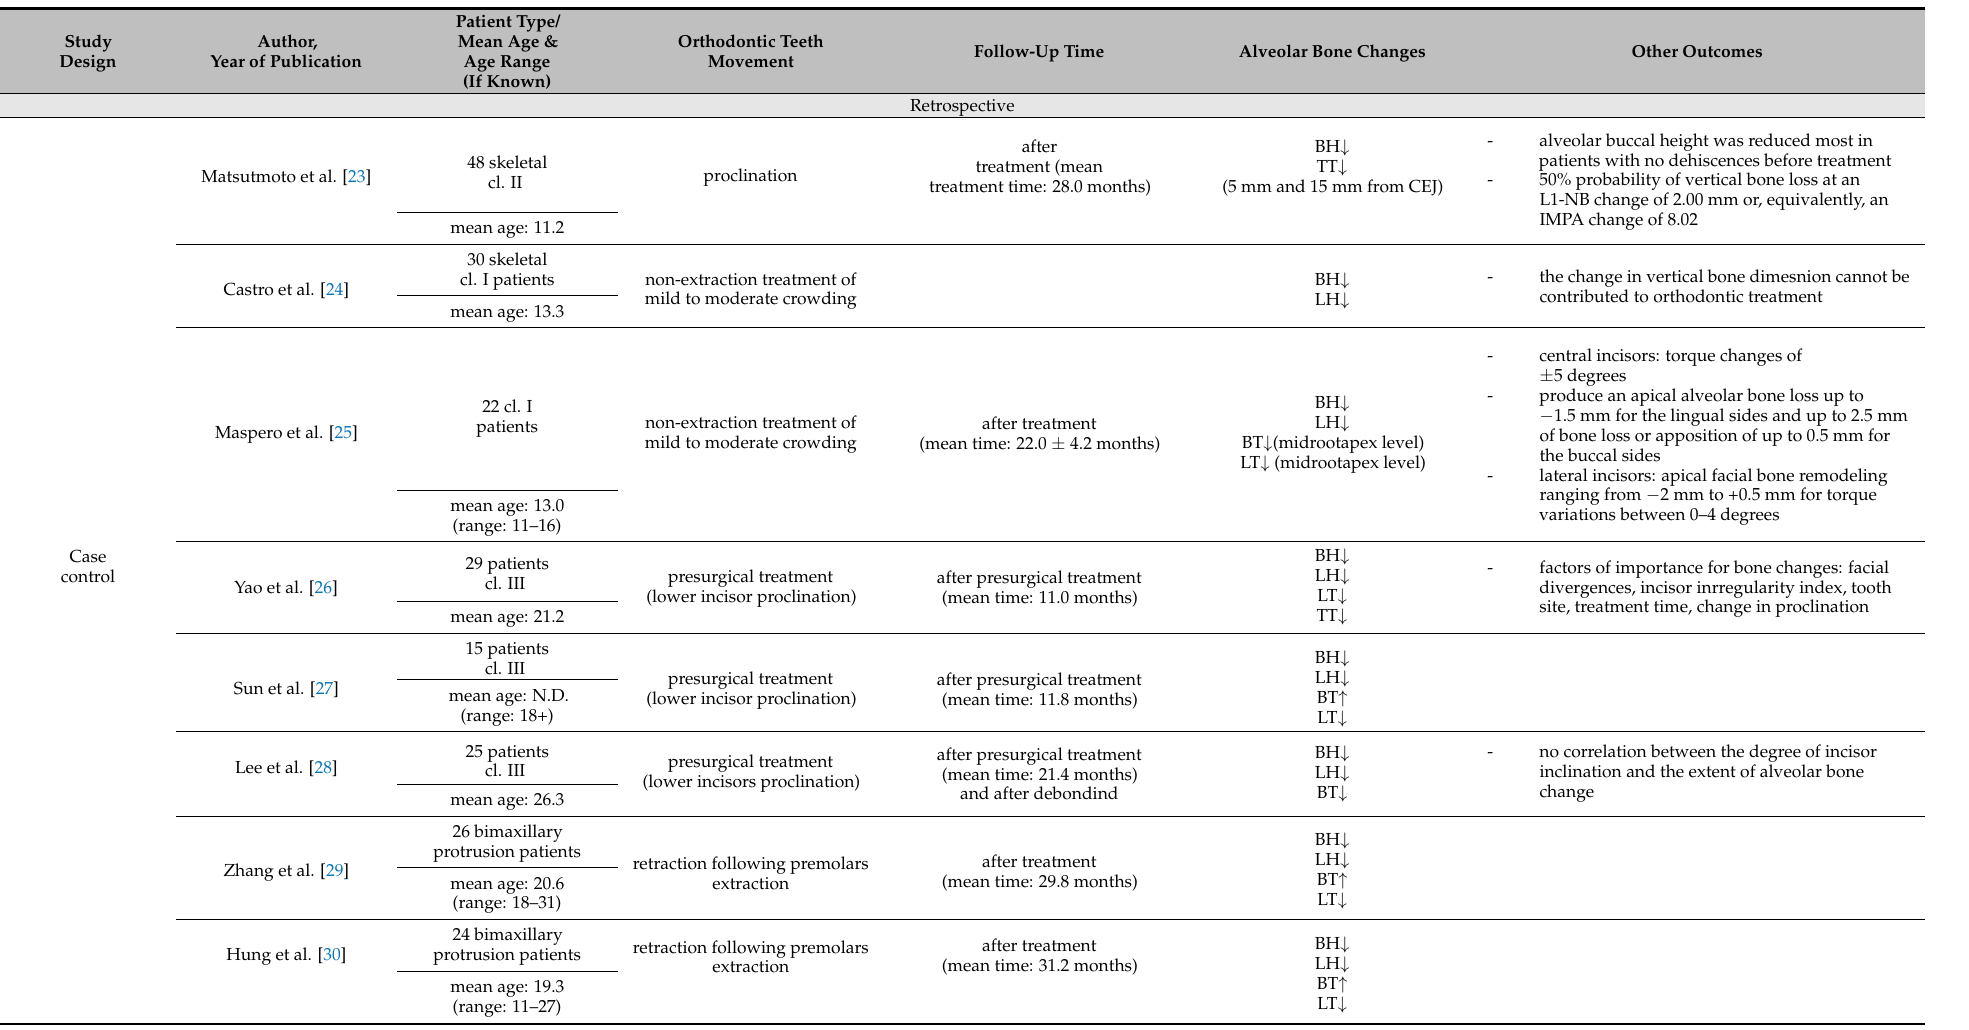
Table 1. Main outcomes of the studies analyzing changes in alveolar bone dimensions around mandibular incisors during orthodontic